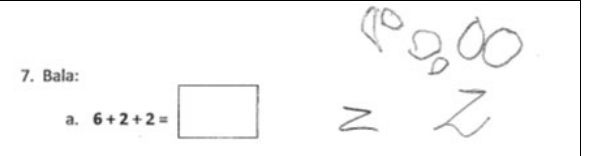
Excerpts from grade 2 learners’ work add to the insight gained from the grade 1 scripts into learners’ use of unit counting in their solution of mathematical